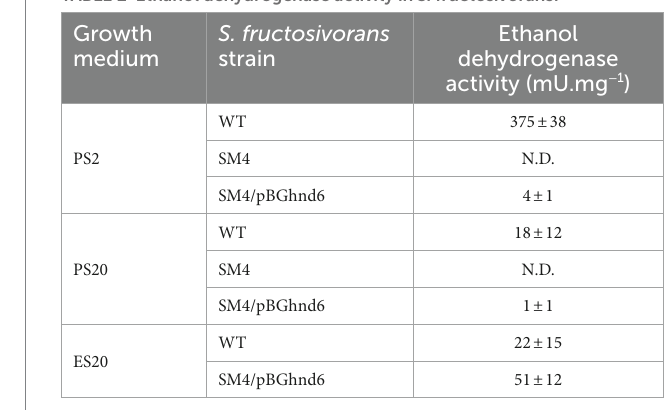
FIGURE 4 Adh level in S. fructosivorans under pyruvate and ethanol conditions. (A) Coomassie blue-stained SDS-PAGE of soluble proteins from S. fructosivorans WT strain grown with pyruvate (PS20, lane 1 or PS2, lane 2) or ethanol (ES20, lane 3) as carbon source. Cells were harvested at stationary phase of growth. Ten micrograms of soluble proteins were loaded in each lane of a 12% SDS-PAGE. Molecular mass markers (lane M) are indicated in kDa. Arrow indicates bands corresponding to Adh (3929). The theoretical molecular mass of Adh is 41.9 kDa. (B) Relative Adh level determined by quantitative proteomics. S. fructosivorans WT and SM4/pBGhnd6 strains were grown with pyruvate (PS2) or ethanol (ES20) as carbon source and cells were collected at stationary phase of growth. Data represent the averages of the results of three experiments. Error bars